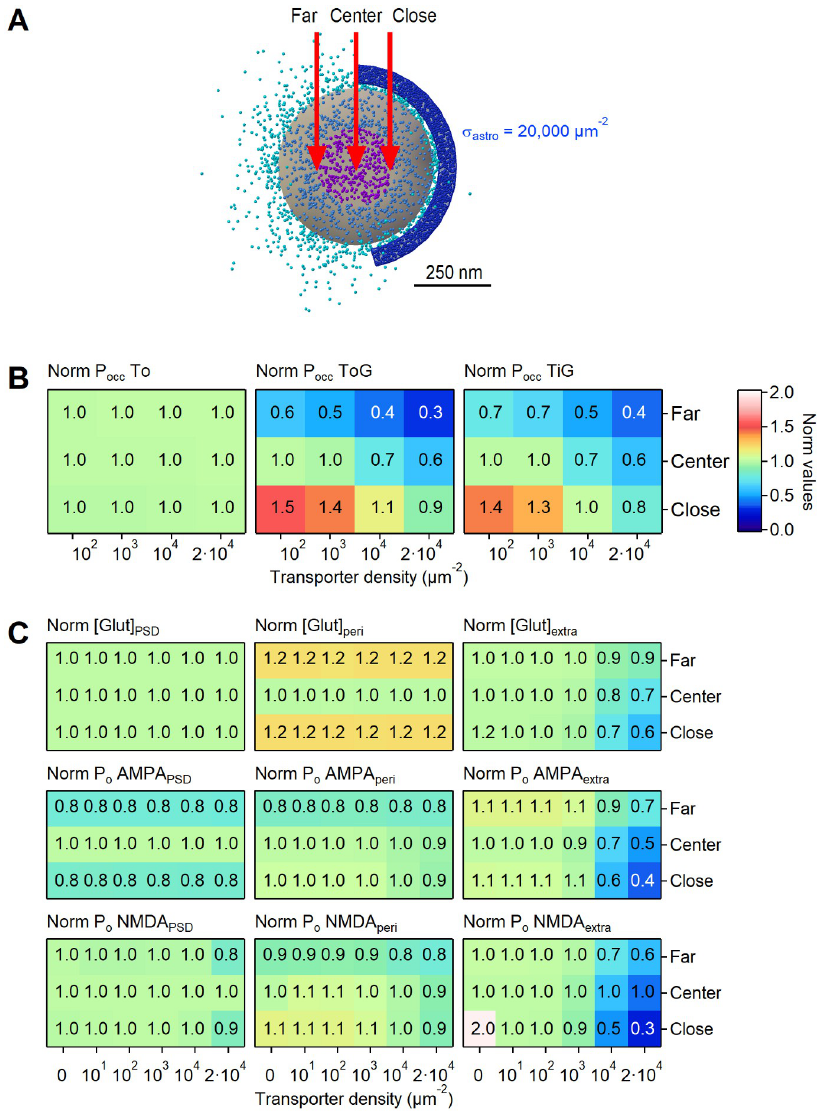
Fig 7. Varying the glutamate transporter surface density has more profound effects on receptor activation if the release site is located closer to the glial sheet. A . Close-up view of the synaptic cleft. Glutamate molecules diffusing in the PSD ( purple ) and perisynaptic portion of the cleft ( cerulean ), and in the extracellular space out of the synaptic cleft ( cyan ). The three red arrows point to the location of the glutamate release site in different three sets of simulation. Its location was either (i) above the center of the PSD ( center ), or at its edges, (ii) close or (iii) far from the glial sheet. In this figure, the surface density of glutamate transporters was set to σ astro = 20,000 μm − 2 . B . Summary graph, showing how the probability of occupancy of the To ( left ), ToG ( center ) and TiG states ( right ) varies depending on the location of the glutamate release site. The data are normalized by the values obtained with σ astro = 100 μm − 2 (trough for To and peak for ToG and TiG), and a release site located above the center of the PSD. C . Summary graph, showing how the peak glutamate concentration ( top ) and peak open probability of AMPA ( middle ) and NMDA receptors ( bottom ) varies depending on the location of the glutamate release site. The estimates were obtained for the PSD ( left ), perisynaptic ( center ) and extrasynaptic regions ( right ). The data are normalized by the values obtained with σ μm − 2 , and a release site located above the center of the PSD. For clarity, error bars are not included in this figure.